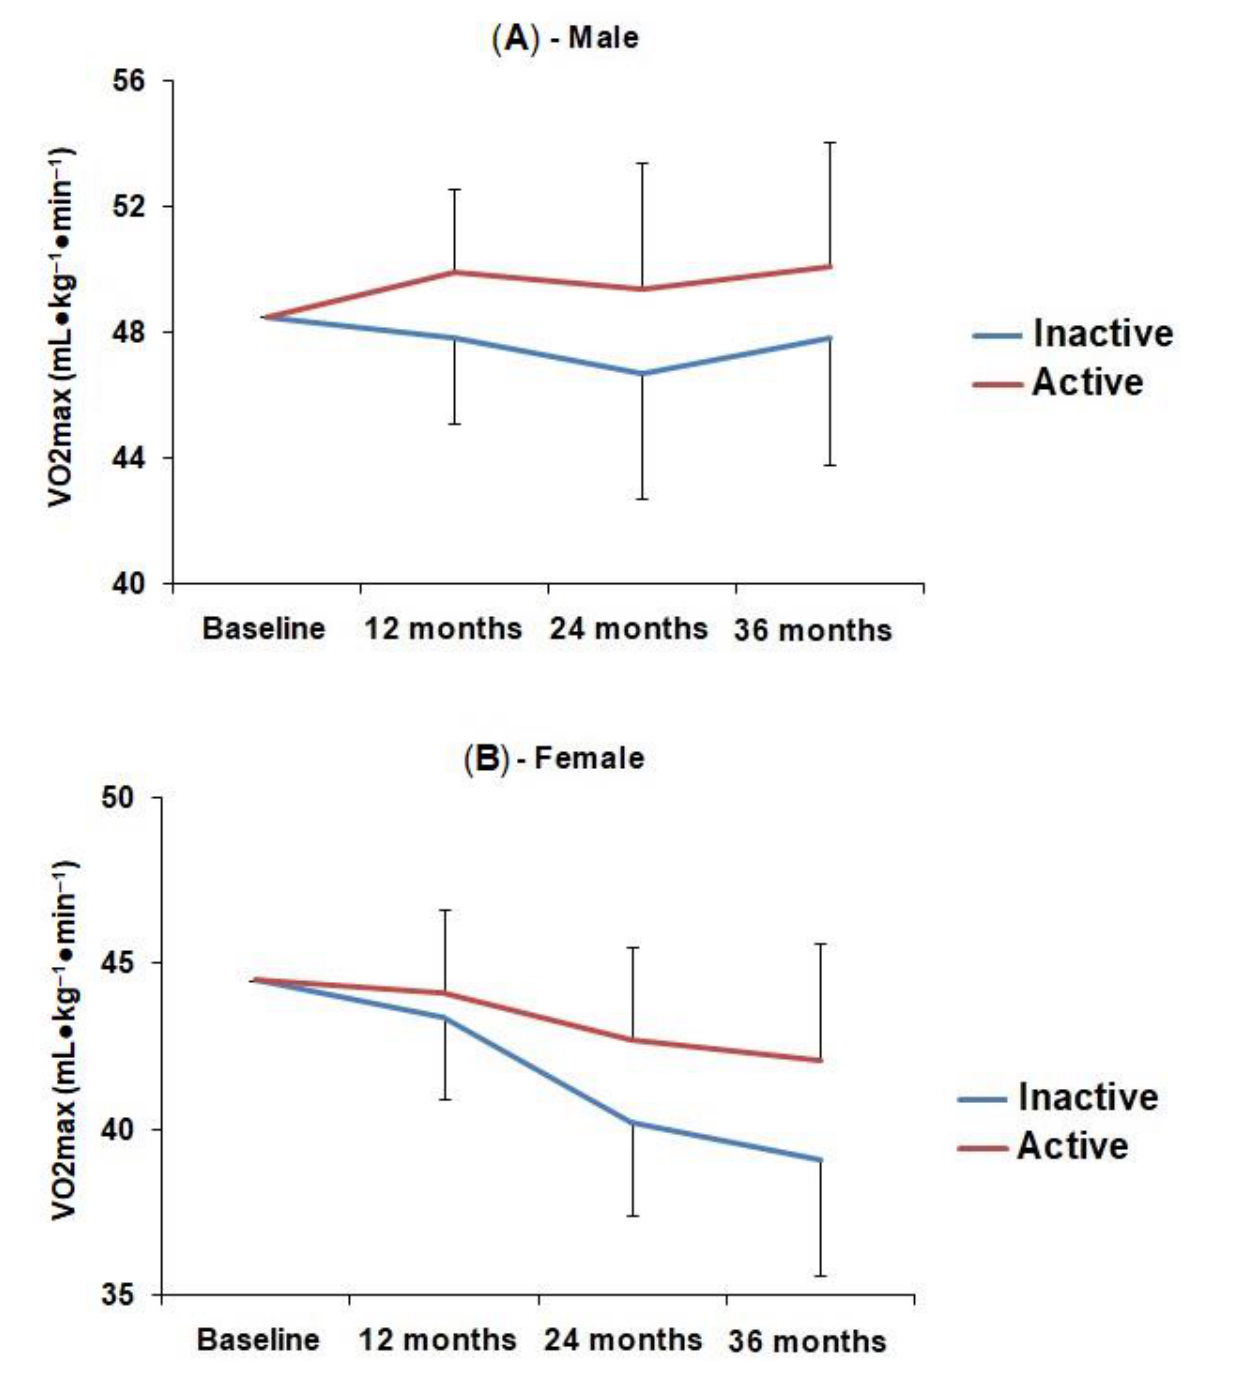
Figure 3. Mean and standard deviation of maximum oxygen uptake in males ( A ) and females ( B ) according to the level of physical activity over the 36-month study period. ( B ) according to the level of physical activity over the 36-month study